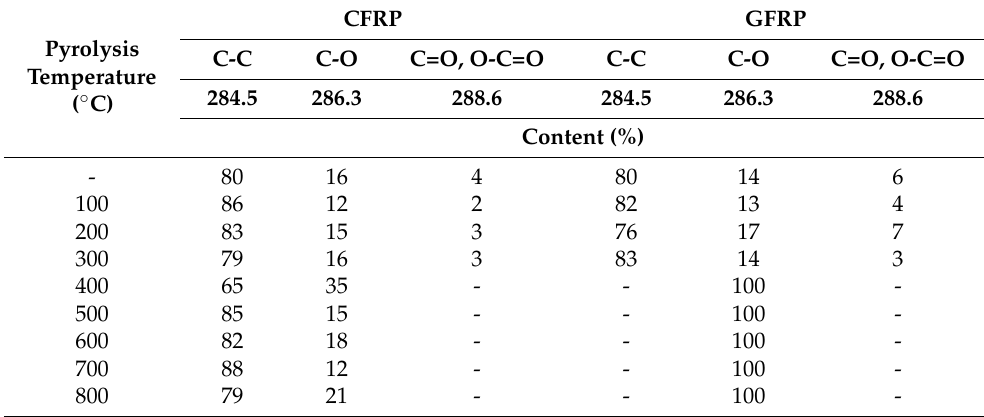
Figure 5. Functional amounts of fibers obtained from FRP analysis according to pyrolysis temperature. Table 8. Functional groups of fibers obtained from FRP analysis according to pyrolysis temperature.